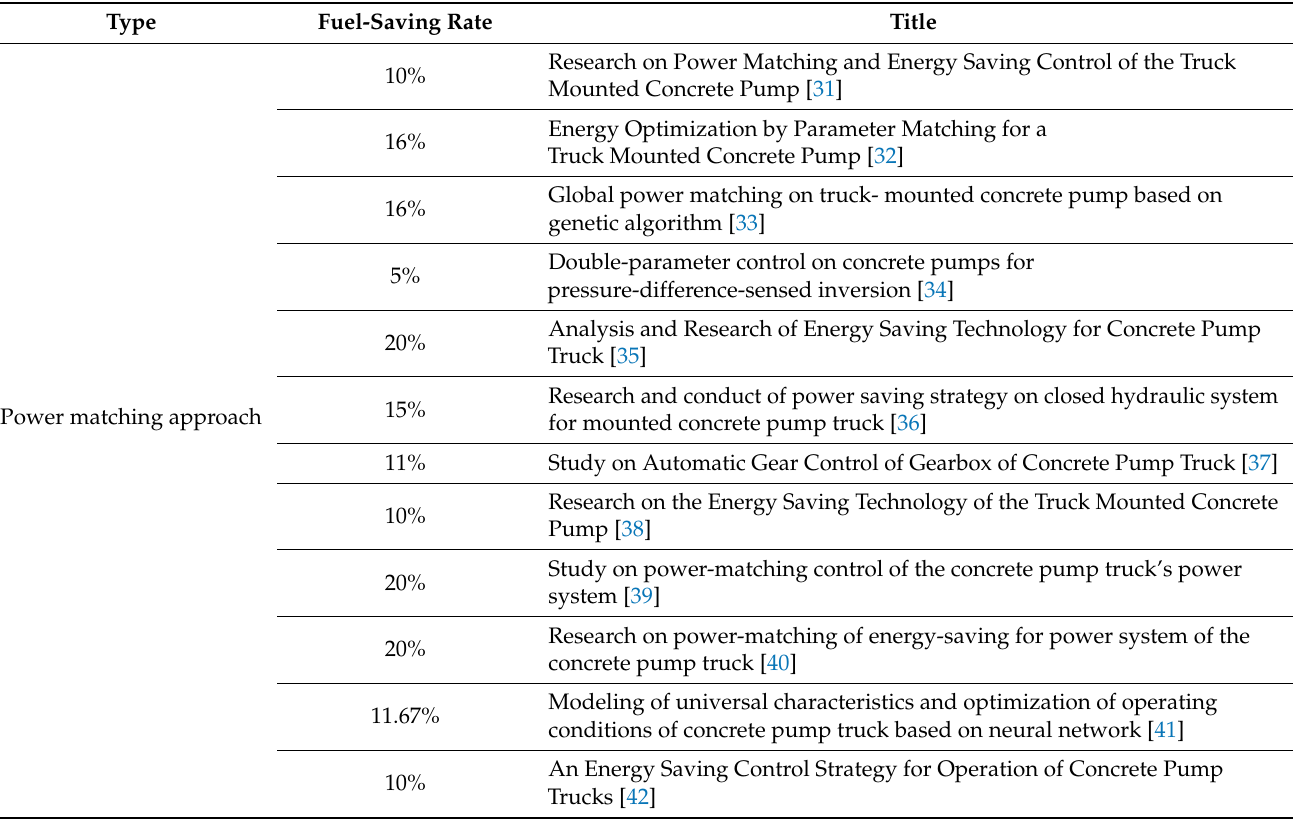
Table 1. Classification of methods for energy conservation of concrete